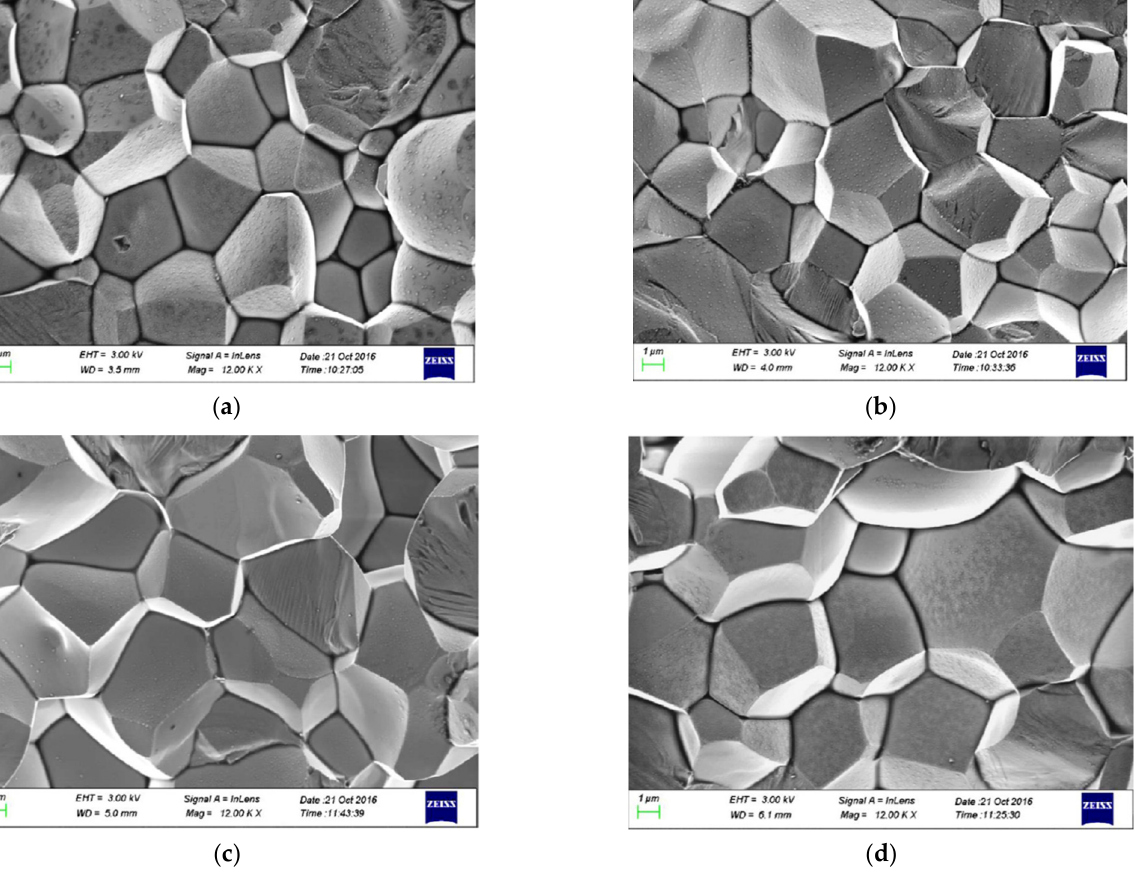
Figure 16. SEM images of PMN-PT polycrystals; ( a ) 1275 °C, 30 min: average grain size (2.7 μ m); ( b ) 1275 °C, 60 min: average grain size (3.2 μ m); ( c ) 1300 °C, 90 min: average grain size (3.8 μ m); ( d ) 1300 °C, 120 min: average grain size (4.3 μ m) [98]. Reprinted with permission from Ref. [98].